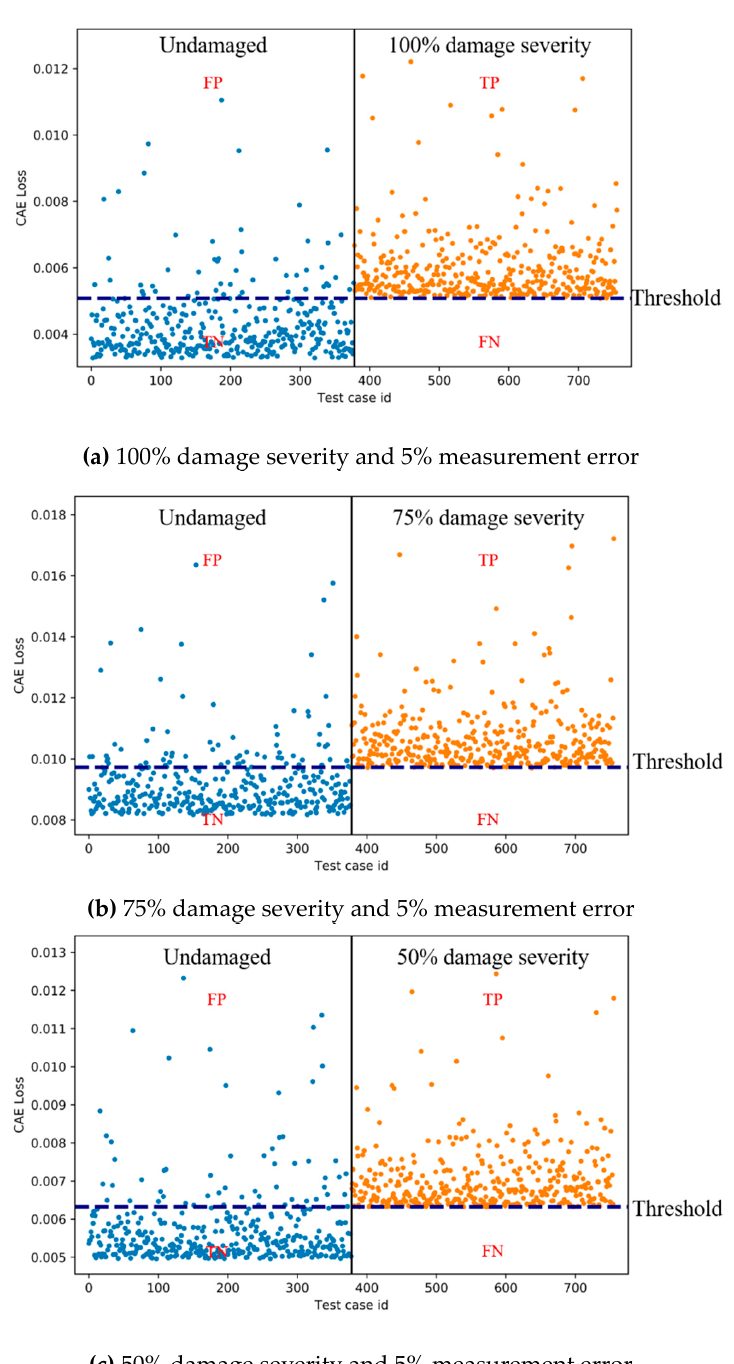
Figure 13. Examples of CAE losses of test data from both undamaged and damaged states for single-vehicle traffic load (TP indicates true and positive. FP indicates false and positive. TN indicates true and negative. FN indicates false and negative. True means that the CAE correctly detected the state of bridge. False means that the CAE incorrectly detected the state of bridge. Positive means that the predicted state is the damaged state. Negative means that the predicted state is the undamaged state).